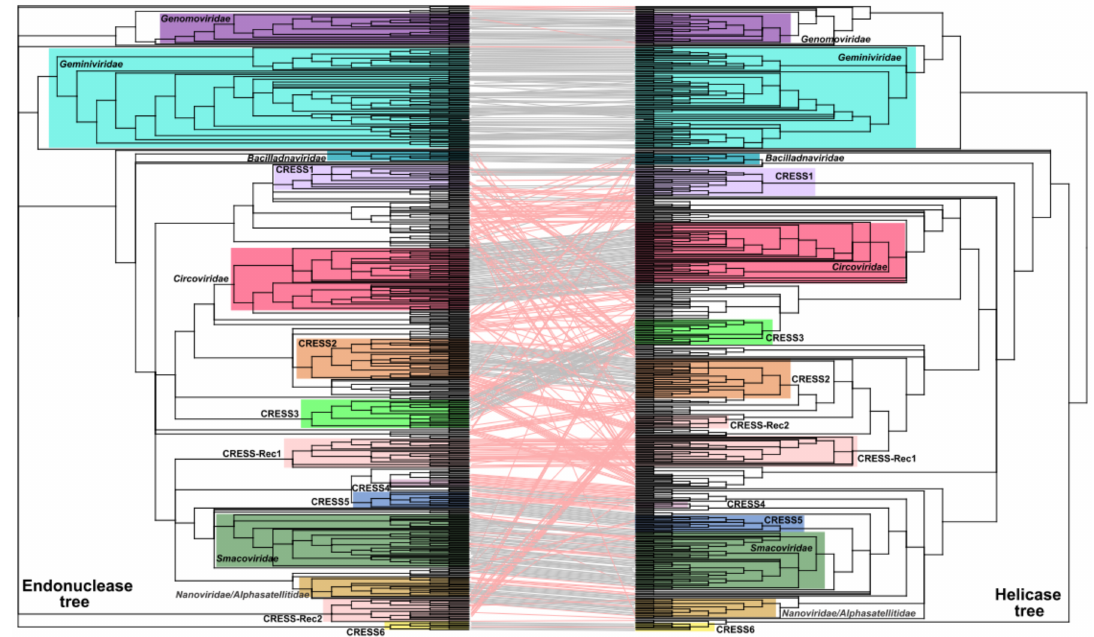
Figure 1. Tanglegram of maximum likelihood phylogenetic trees of the nuclease (left) and helicase (right) domains of Reps encoded by circular, Rep-encoding single-stranded (CRESS) DNA viruses. Putative recombinant proteins are joined with red lines. Clades forming distinct groups are marked with colored rectangles. Branches with support lower than 70% were collapsed. The nuclease and helicase phylogenies were inferred using PhyML [32] with the VT + G (VT matrix; G, gamma shape parameter) and rtREV + G + I + F (rtREV amino acid model; G, gamma shape parameter: fixed; I, proportion of invariable sites: fixed; F, equilibrium frequencies: empirical) substitution models, respectively. The alignments contained 267 and 206 aa positions, respectively. Rec, recombinant Rep